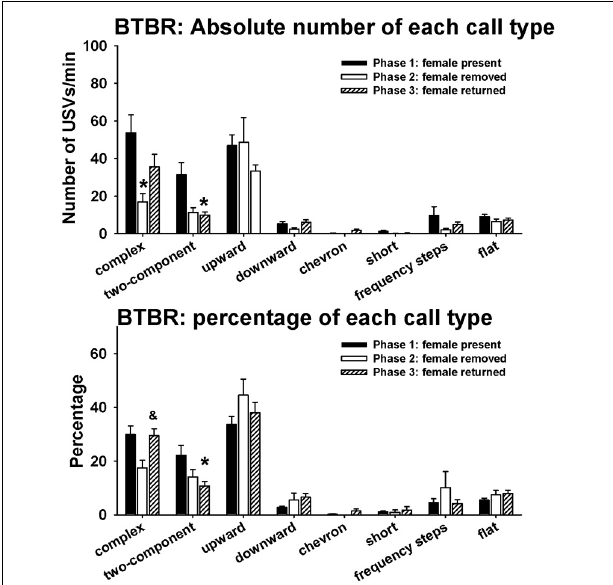
FIGURE 6 | Call repertoires in BTBR males in phases 1, 2, and 3. USVs were detected from 9 out of 11 BTBR in phase 1, 4 out of 11 BTBR in phase 2, and 9 out of 11 BTBR in phase 3. Only animals that emitted USVs were included in call category analysis. Analysis of absolute call numbers indicated significant phase effects on complex and two-component. Number of complex was lower in phase 2 than in phase 1. Number of two-component was lower in phase 3 than in phase 1. Analysis of percentages of call types indicated significant phase effects on complex and two-component. A trend was found for the percentage of complex to decrease in phase 2. The percentage of complex was higher in phase 3 than in phase 2. The percentage of two-component was lower in phase 3 than in phase 1. ∗ p < 0 . 05 vs. phase 1; & p < 0 . 05 vs. phase